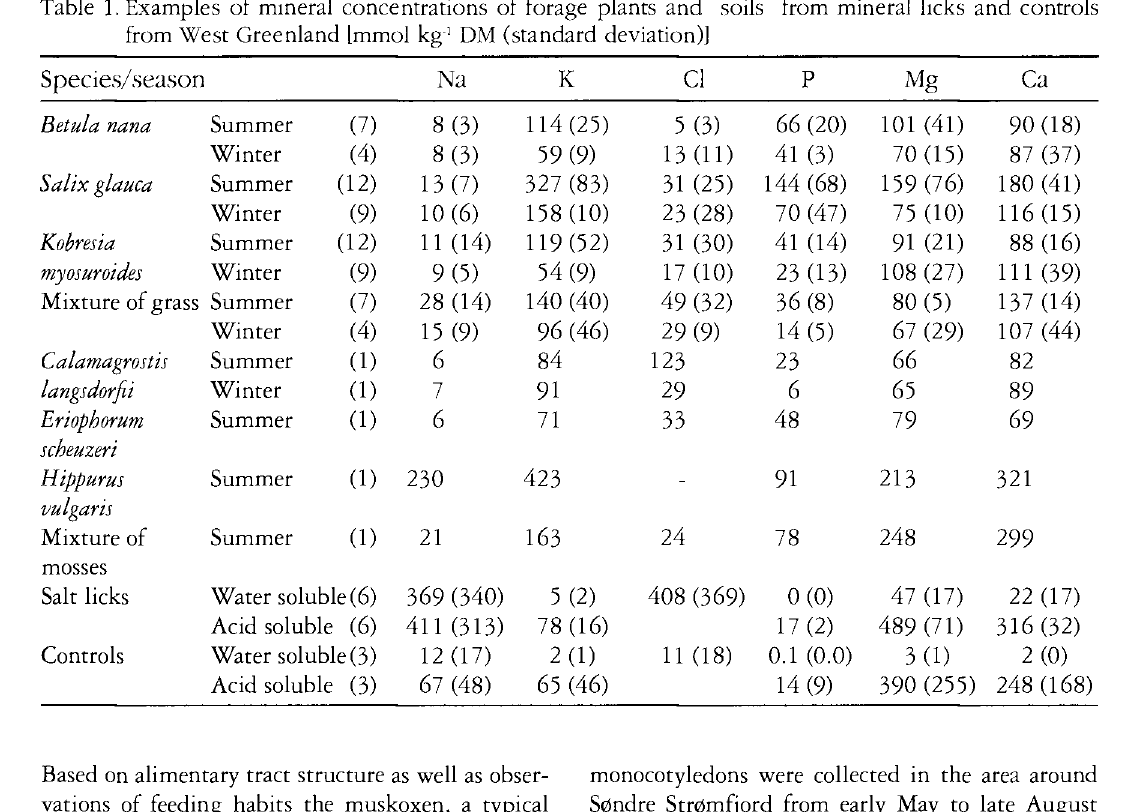
Table 1. Examples of mineral concentrations of forage plants and soils from mineral licks and controls from West Greenland [mmol kg 1 DM (standard deviation)]